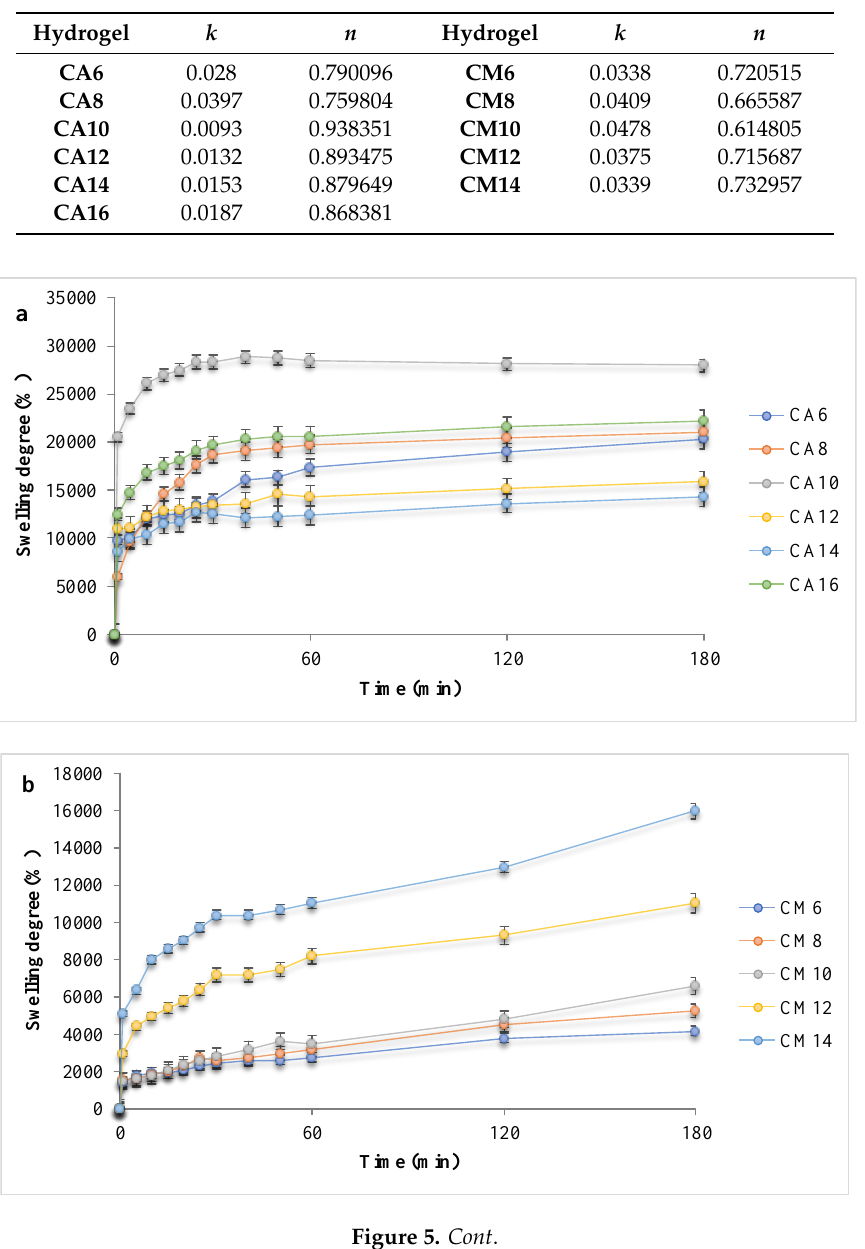
Table 3. Kinetic parameters for hydrogels without arginine, immersed in PBS.